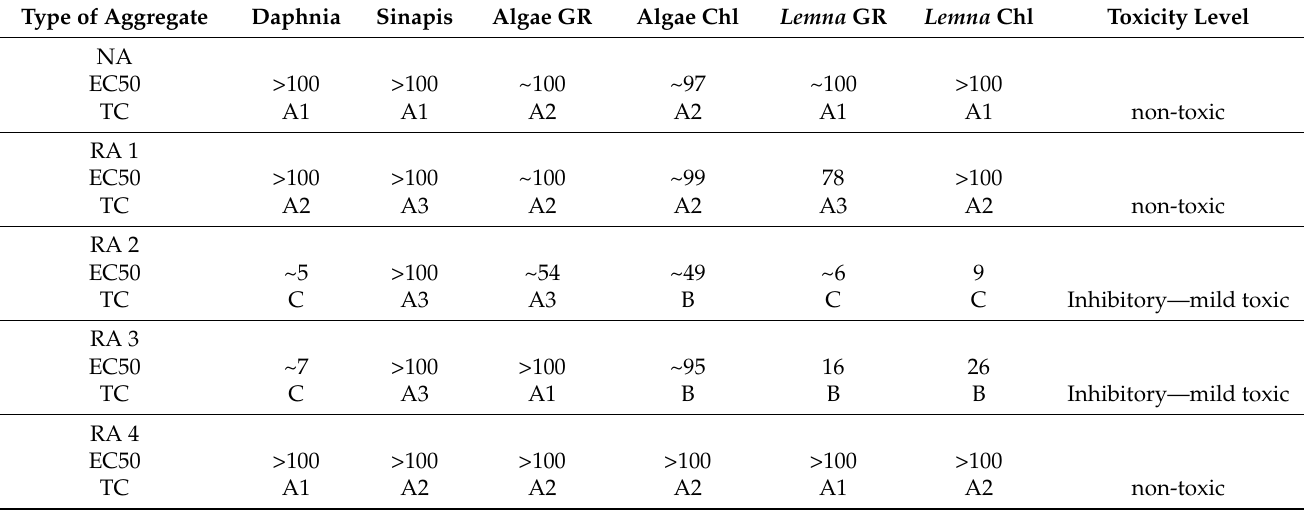
Table 5. EC50 values and ecotoxicity assessment of leachates. GR—growth rate; chl—chlorophyll content; TC—toxicity